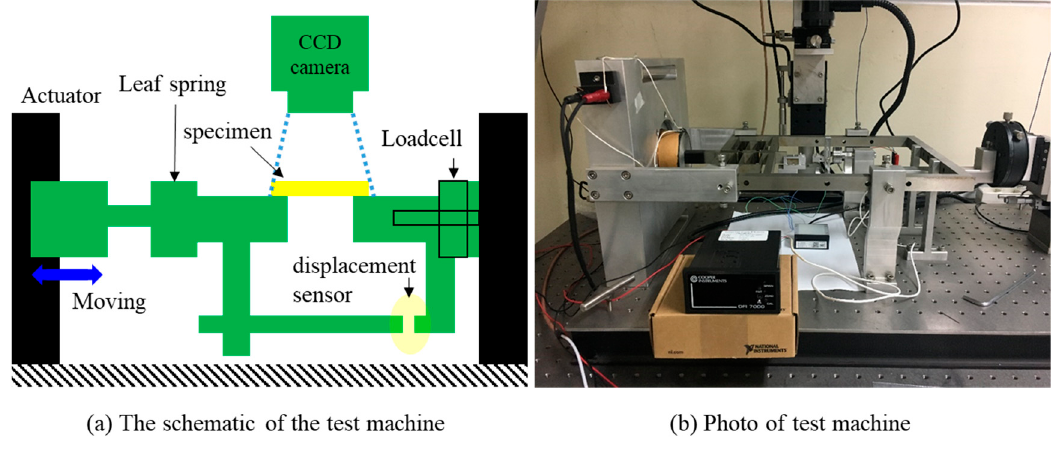
Figure 4. The system configuration for tensile and fatigue testing.